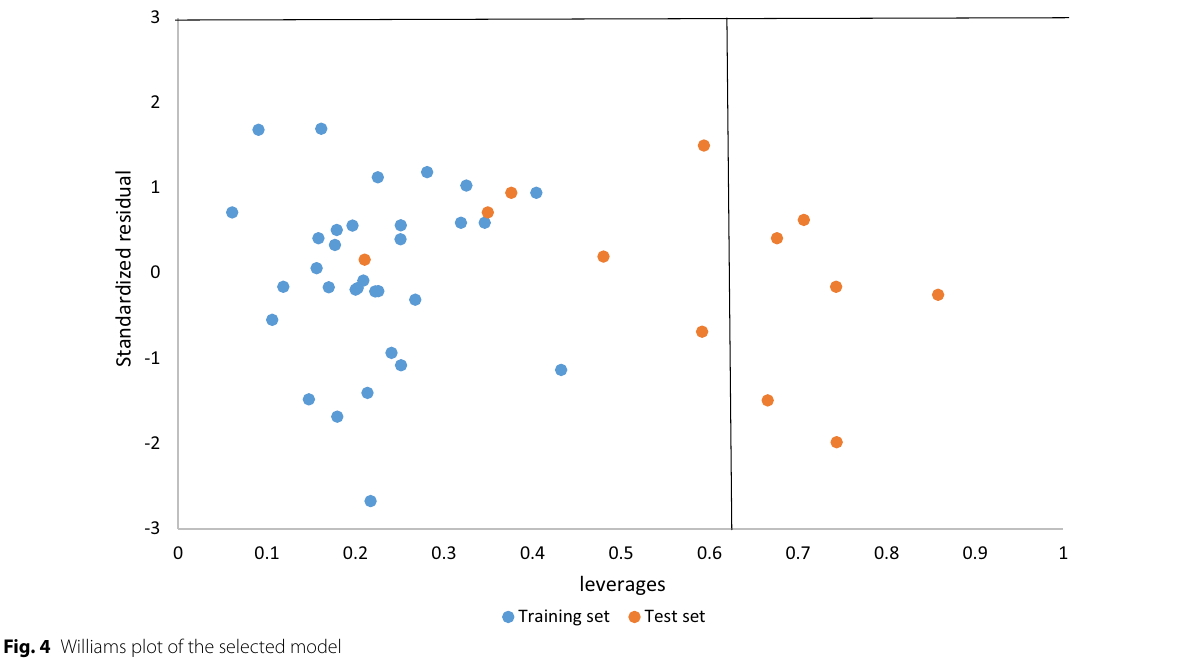
Fig. 4 Williams plot of the selected model